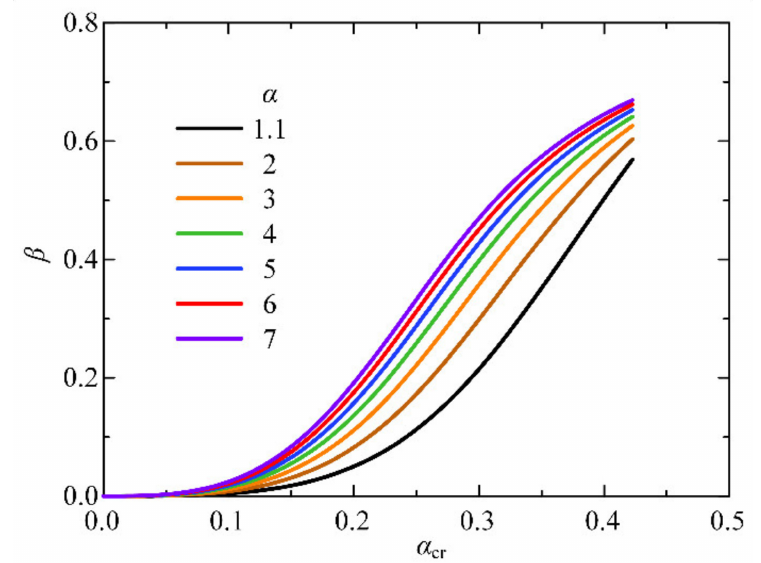
Figure 15. Variation in equivalent stiffness weight coefficient β with parameters α and α cr